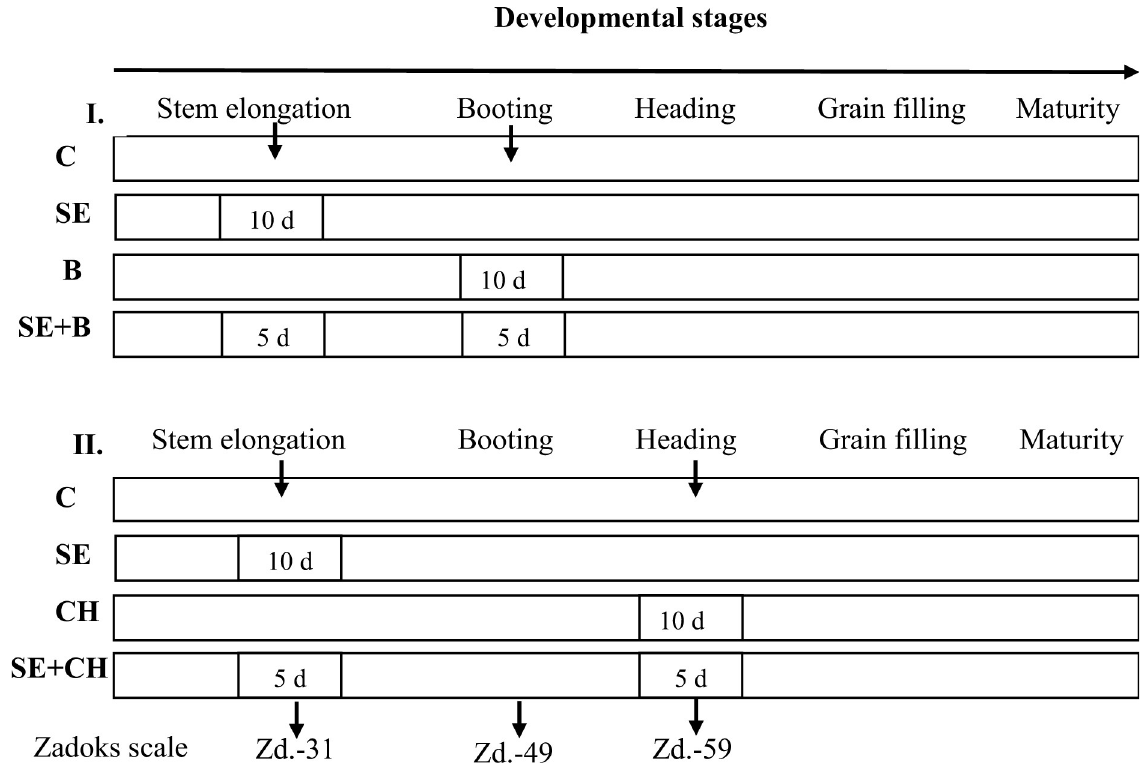
Fig 1. The experimental design of the two heat stress experiments. C refers to no heat stress treatment-control; SE refers to 10 days of heat stress treatment at the stem elongation stage; B refers to 10 days of heat stress treatment at the booting stage; CH refers to 10 days of heat stress treatment at full heading; SE+B refers to 5 days of heat priming at the stem elongation stage + 5 days of heat stress at the booting stage; and SE +CH refers to 5 days of heat priming at the stem elongation stage + 5 days of heat stress at full heading.